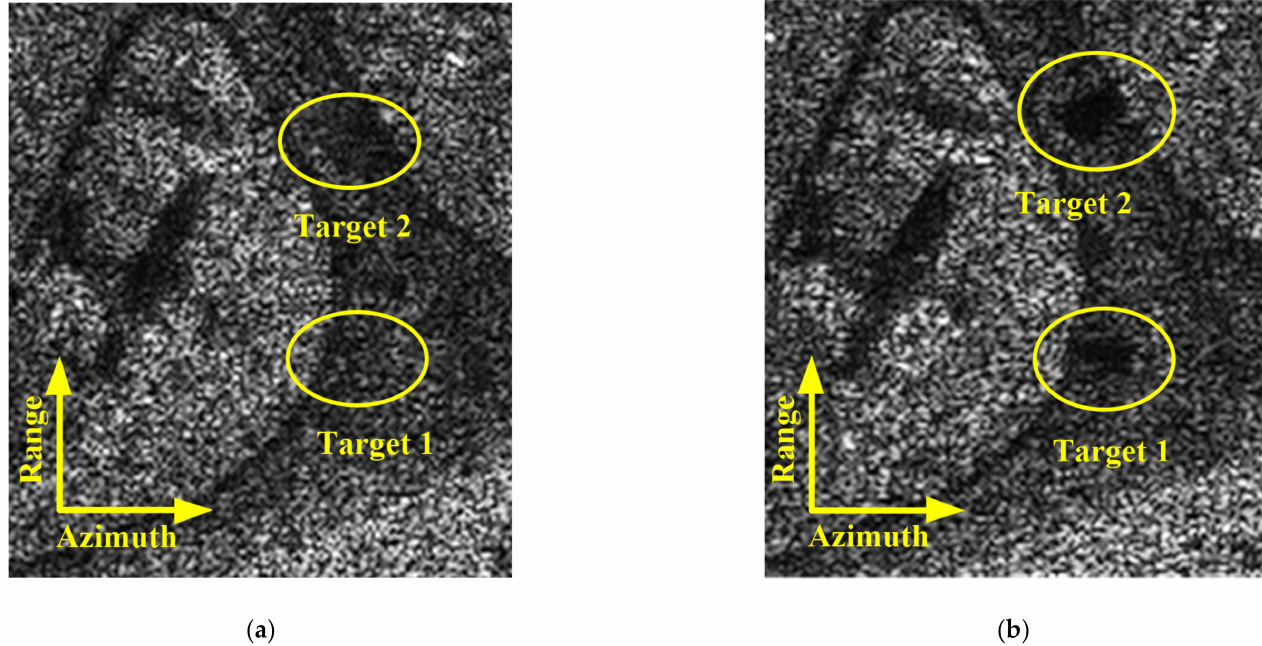
Figure 21. Localized results with Target 1 and Target 2. ( a ) and ( b ) are the results of X-band and Ka-band,